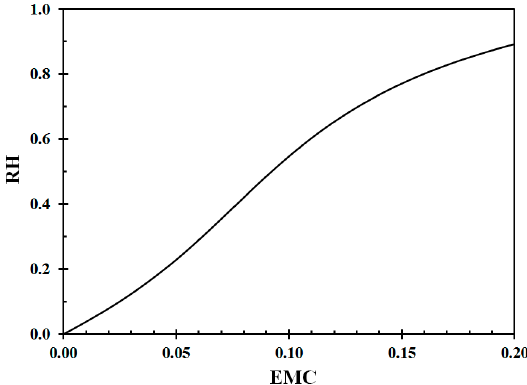
Figure A2. Relative humidity (RH) as a function of equilibrium moisture content (EMC) at 22 °C. Data from Equation (A6) [44].